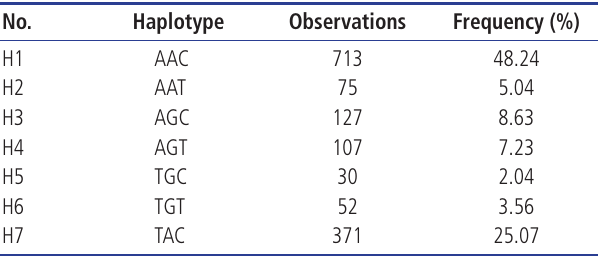
Table 5. Haplotypes based on SNPs of rs13997809, rs13997811, and rs13997812 in the UCP3 gene No. Haplotype Observations